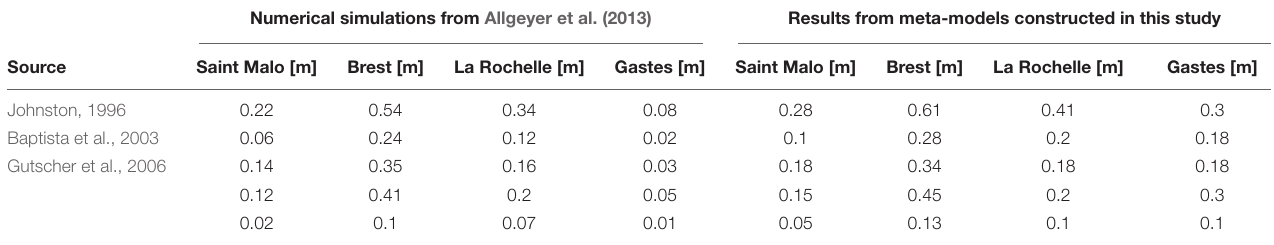
TABLE 7 | Maximum tsunamis height simulated in Allgeyer et al. (2013) for the 1755 Lisbon-tsunami and computed with meta-models. Numerical simulations from Allgeyer et al.